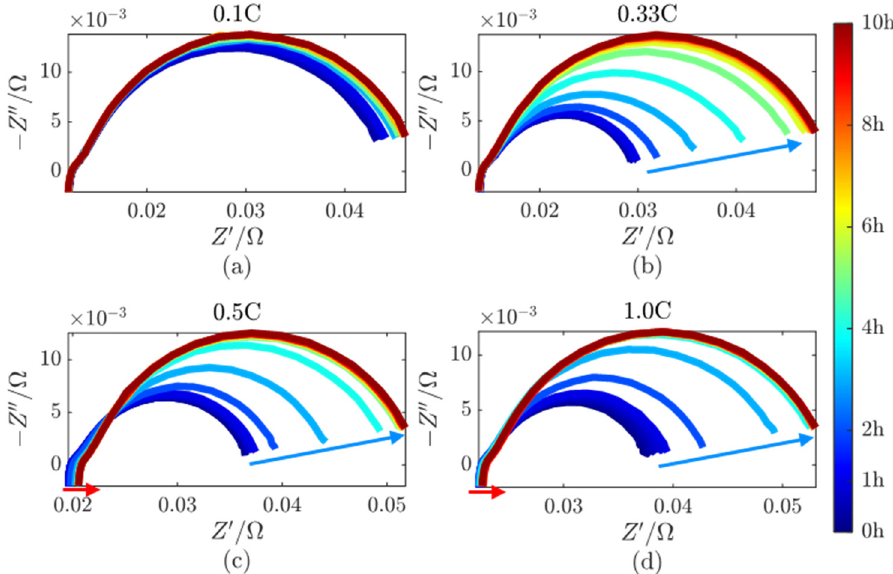
Figure A1. The electrochemical impedance spectrum of ( a ) experiment #1-1; ( b ) experiment #1-2; ( c ) experiment #1-3; ( d ) experiment #1-4. A clear right shift can be seen when comparing the impedance results recorded at different C rates, which is caused by the degradation, specifically the internal resistance increase, of the battery after each low temperature